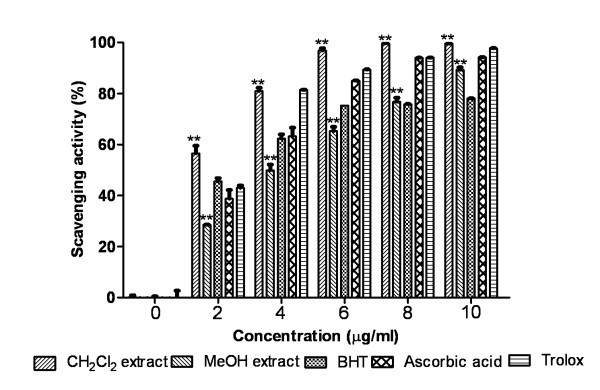
Total antioxidant activity. Effect of Dragon's blood resin extracts and standards BHT, ascorbic acid, trolox on ABTS radical cation decolorization assay. The percentage of inhibition was plotted against concentration of samples. **P < 0.0001 vs 0 μg/ml.